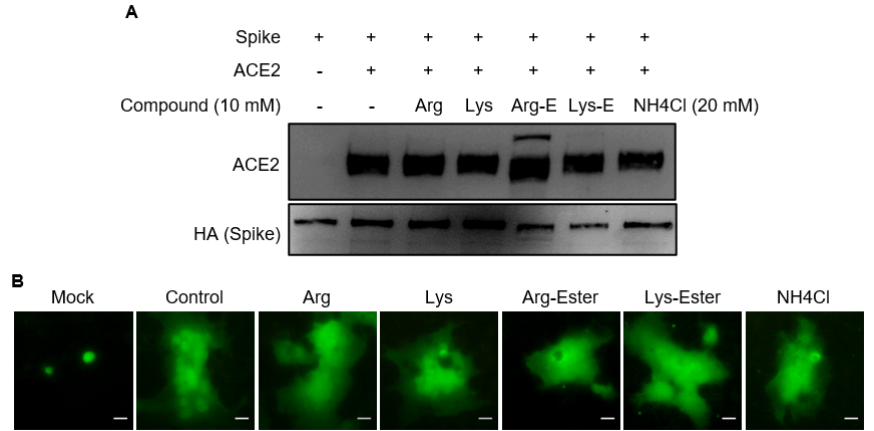
Figure 3. Effects of compounds on the interaction between SARS-CoV-2 Spike and ACE2. ( A ) HEK293T cells were transfected with either HA-tagged SARS-CoV-2 Spike or ACE2. Equal amounts of Spike-expressing and ACE2-expressing cell lysates were mixed, incubated with or without the compounds, and were used for immunoprecipitation assay using anti-HA agarose. The immunoprecipitates were resolved on SDS-PAGE and immunoblotted with anti-ACE2 or anti-HA antibodies. ( B ) Effects of compounds on SARS-CoV-2 Spike-mediated cell-cell fusion. Mock- or ACE2-transfected H1650 cells were co-cultured with spike and GFP-coexpressing H1650 cells for 4 h in the presence of the indicated compounds (10 mM) or NH 4 Cl (20 nM). Scale bar = 25 µ M.